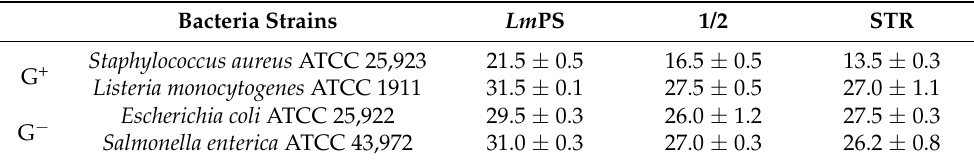
Table 2. Antibacterial activity of Lm PS expressed as inhibition zones. Bacteria Strains